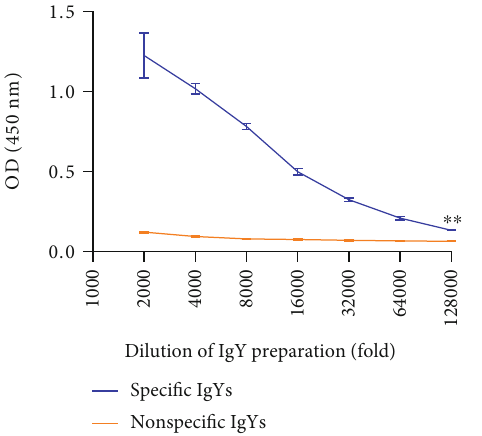
Figure 1: The titers of speci fi c anti- V. vulni fi cus IgYs at di ff erent dilutions as assayed via an indirect ELISA ∗∗ p < 0 : 01 .